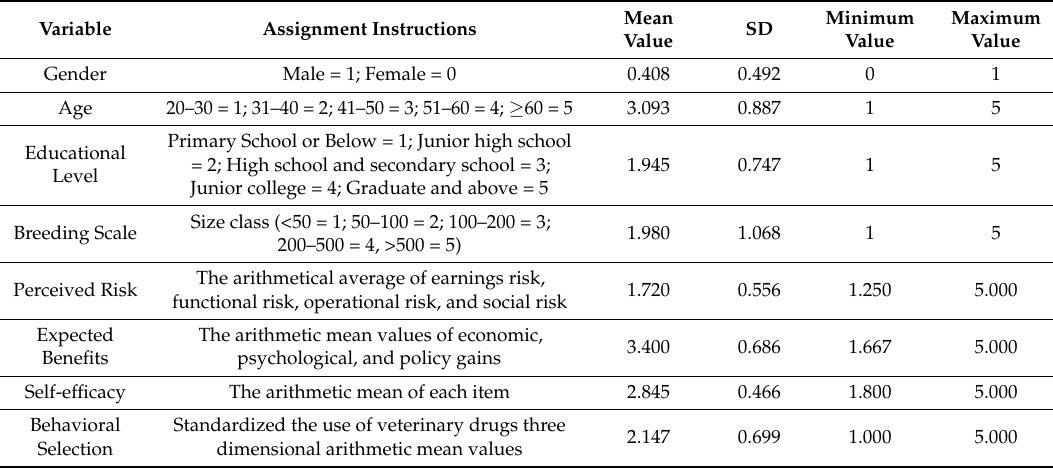
Table 3. Variable assignments and descriptive